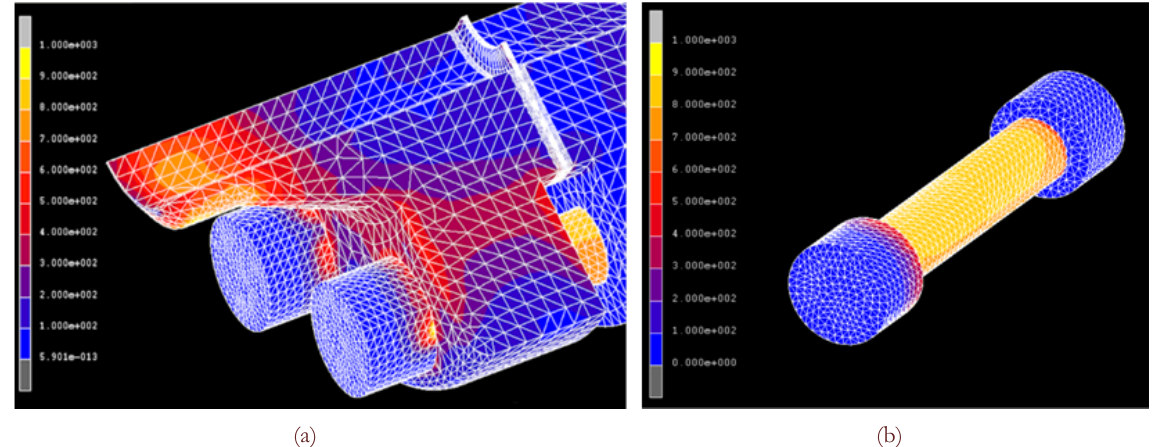
Figure 5: (a) Stress distribution on the model; (b) equivalent stresses on the pivot.